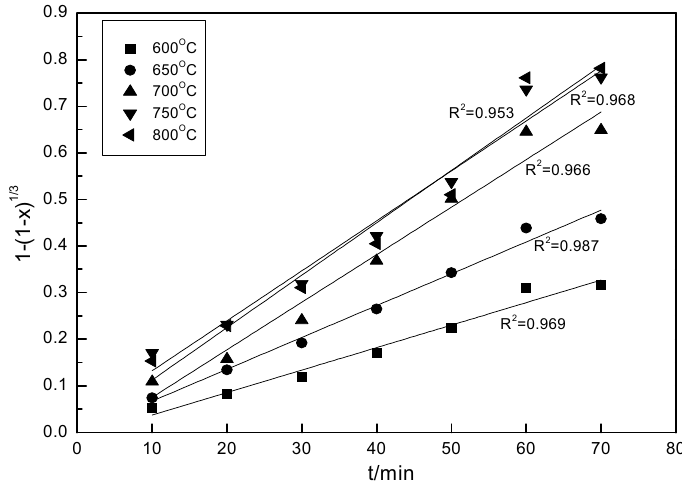
31 1 Figure 7. Plots of vs. time at various temperatures. Figure 7. Plots of 1 − ( 1 − x ) 3 vs. time at various temperatures. )1(1 x −− vs. time at various temperatures. Figure 7. Plots of